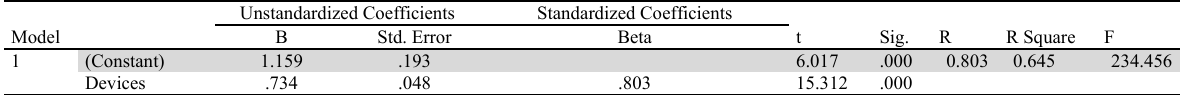
The results of testing the first sub-hypothesis Model